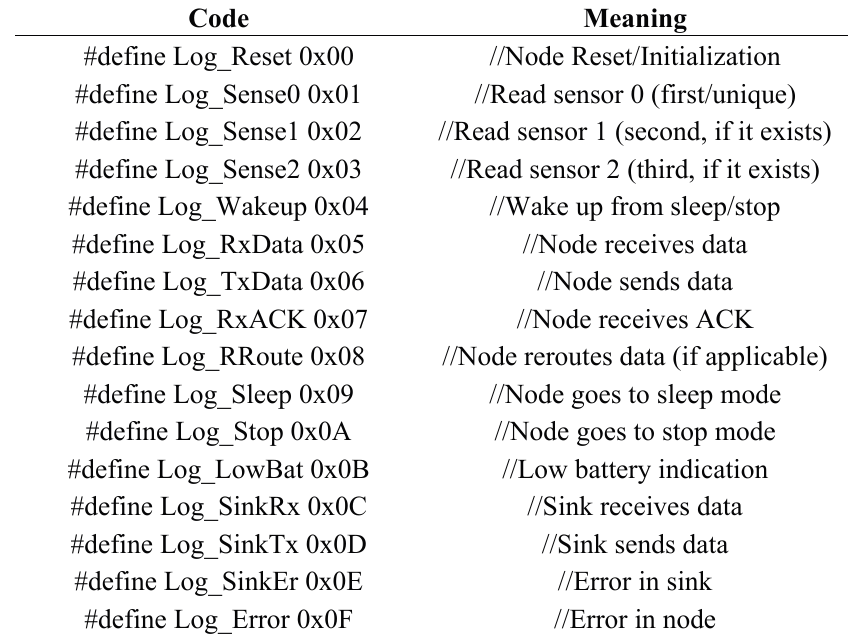
Table 1. Example of 4-bit event